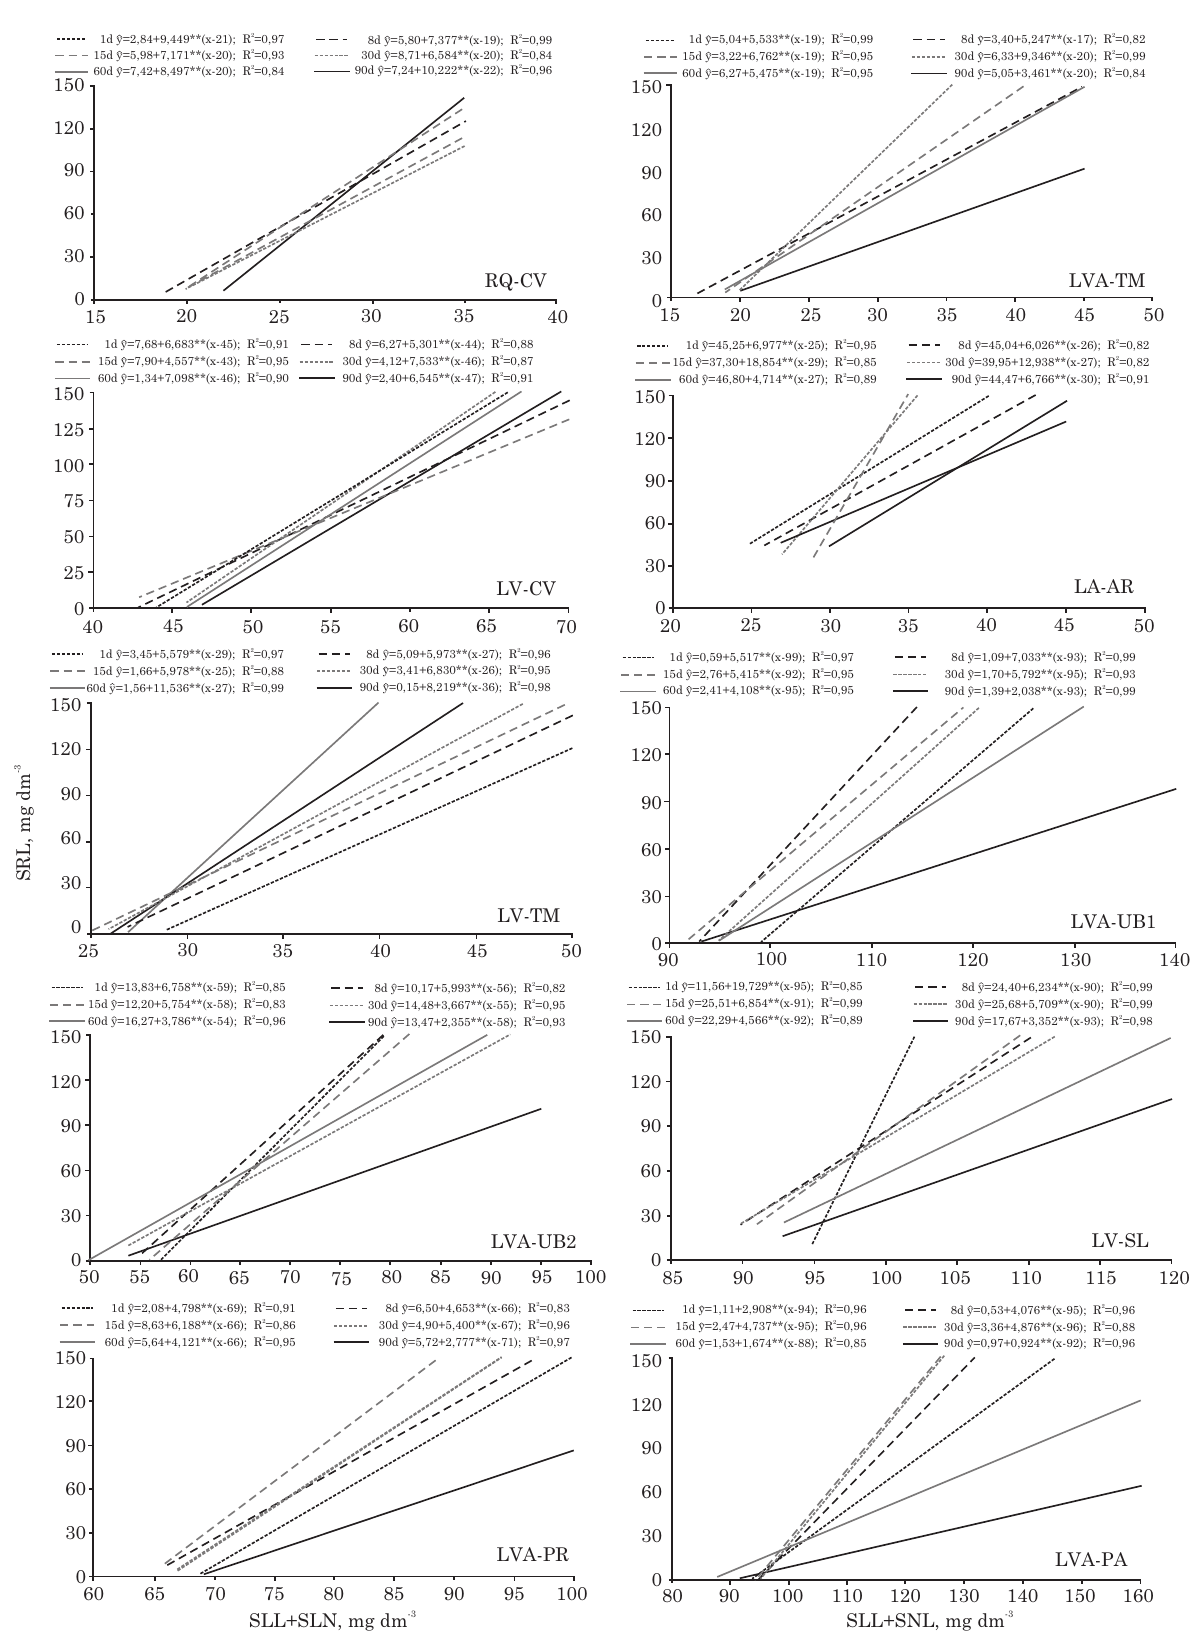
Figura 1. Relação entre os teores de SRL e os de SLL+SNL em diferentes tempos de incubação nos 10 solos estudados.**: significativo a 1